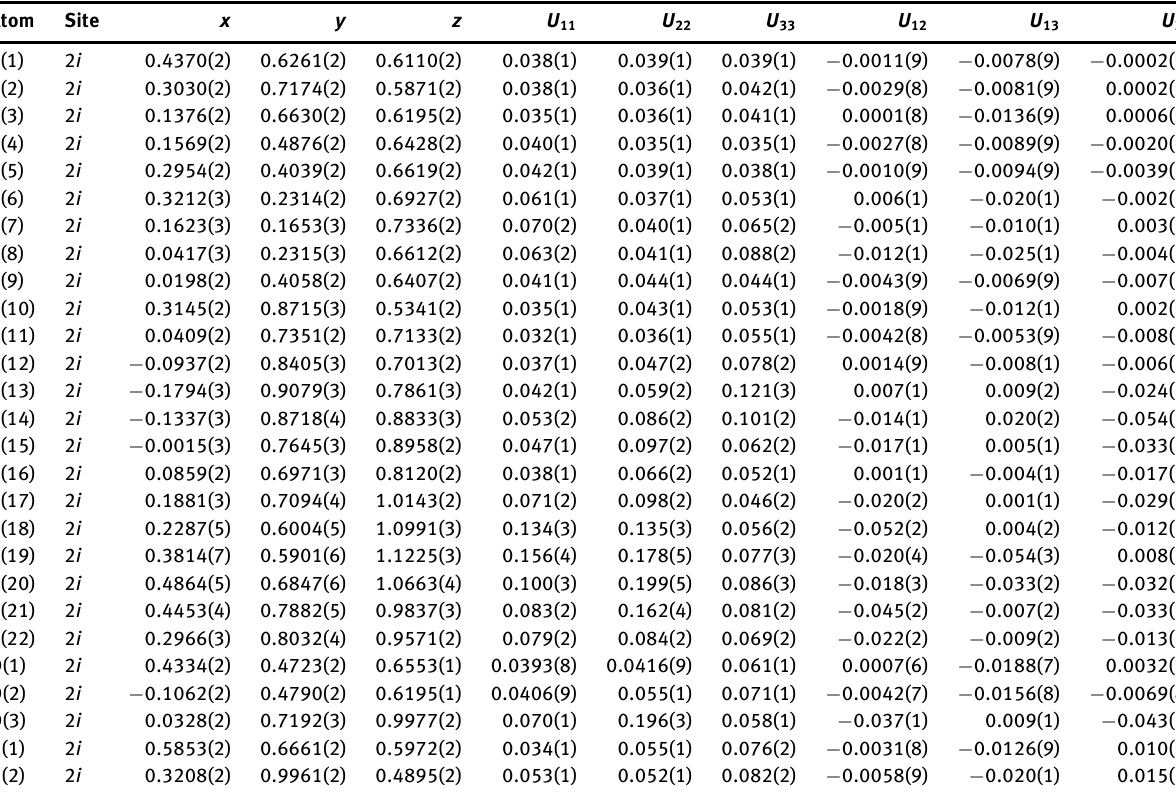
Table 3: Atomic displacement parameters (Å 2